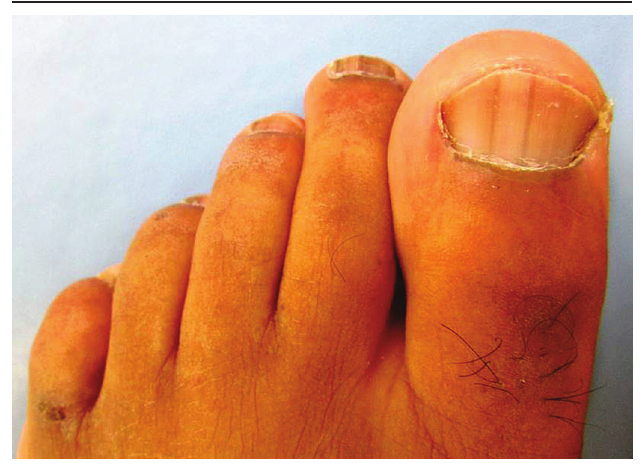
figurE 4 − Longitudinal brownish bands in patient’s toenails taBLE − LHS cases published in the literature in English in the latest 10 years